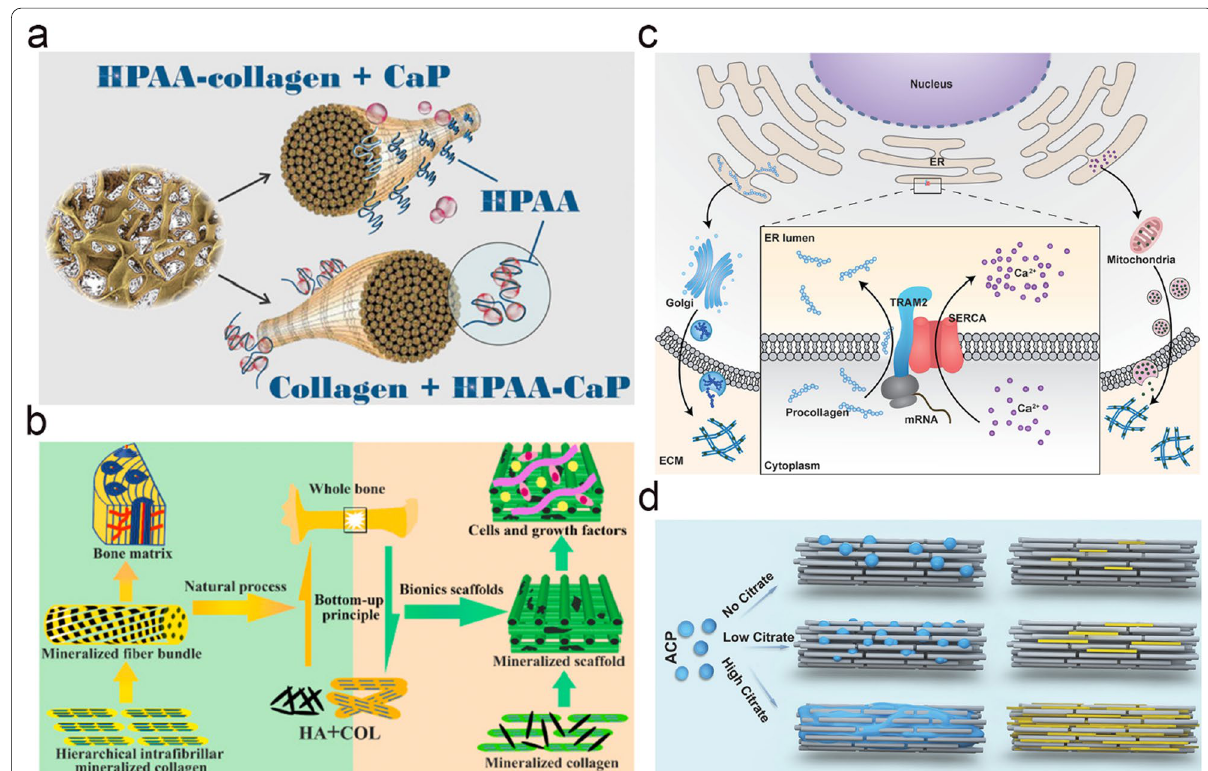
Fig. 3 The mineralized collagen. a Mineralized high–molecular weight polyacrylic acid (HPAA)–cross-linked collagen sponges. Reproduced with permission from [79]; b The natural bone formation process and the bionic strategy of bone repair scaffold. Reproduced with permission from [84]; c Schematic representation of the calcium–collagen coupling. Reproduced with permission from [85]; d Schematic of the functional citrate treatment on the mineralization of collagen fibrils. Reproduced with permission from